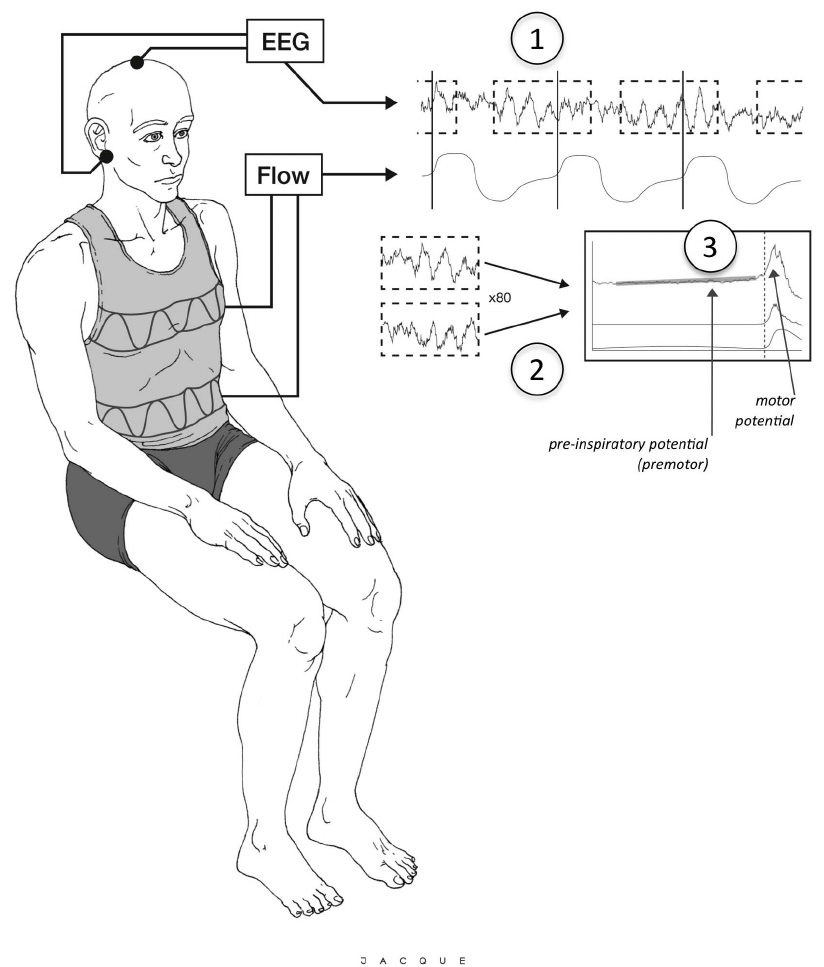
Figure 1. Schematic representation of the method used to identify pre-inspiratory potentials from the raw EEG signal and the ventilatory flow signal. (Adapted from Raux et al., Anesthesiology —[19]—with permission from the authors and the publisher.) Artwork Robin Jacqueline. The EEG signal is segmented in epochs defined according to the ventilatory flow signal (1). These epochs are ensemble averaged (2). The resulting signal is inspected visually for a putative pre-inspiratory potential (3) of which the presence is ascertained through the calculation of a linear regression over the region of interest and comparison of the slope of this regression with 0. See ‘‘Methods’’ for details. Pre-inspiratory potentials and the related motor potentials are normally absent during quiet breathing.